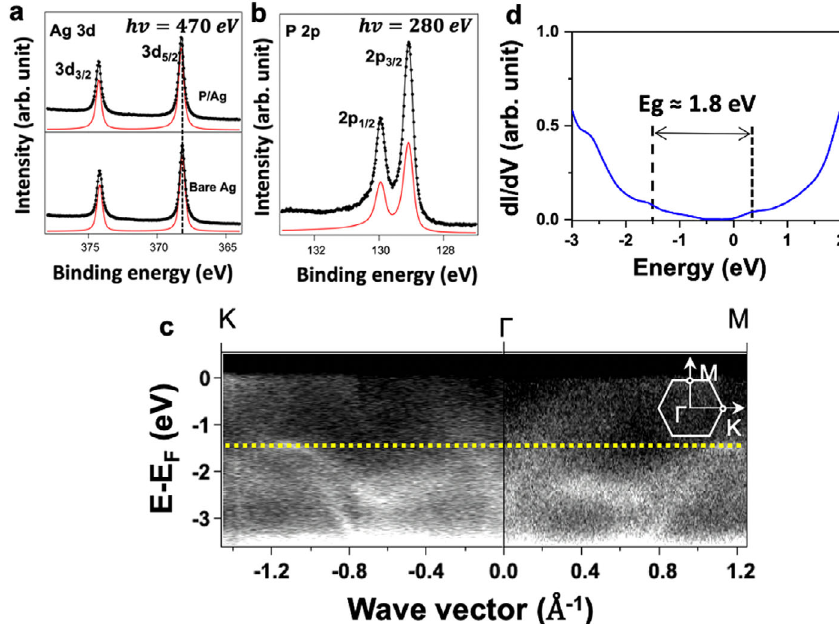
Fig. 3 Experimental XPS, HR-ARPES, and simulated spectra of P chains on Ag(111). a XPS spectra of Ag 3 d core levels before (lower panel) and after growth of P chains (upper panel). b P 2 p core-level spectrum, presenting only one doublet (red curve). (Black dots present the data; black curve presents the best fi t.) c The HR-ARPES were recorded at photon energy of 60 eV along K – Γ – M directions after deposition of P chains on Ag(111) surface. d STS d I /d V spectra acquired on the P chains, demonstrating the semiconducting character of P chains. The curve is an average of 40 individual surface are indicated by blue circles. Following the deposition of P atoms, different spots appear corresponding to a ×3 structure (red circles) with respect to the silver substrate in good agreement with the STM observations. The elongated spots of the ×3 structure indicate that the order is not perfect along this direction. This is due to the shift between two neighboring P chains that we see in the STM images (Fig. 2a). The thin elongated streaks with a ×2 periodicity appear weak in the diffraction pattern (outlined by the yellow dashed line). This weakness is due to an inter P chain shift of one atomic parameter of silver. This behavior was also observed in the case of silicene NRs on Ag(110) 50 .